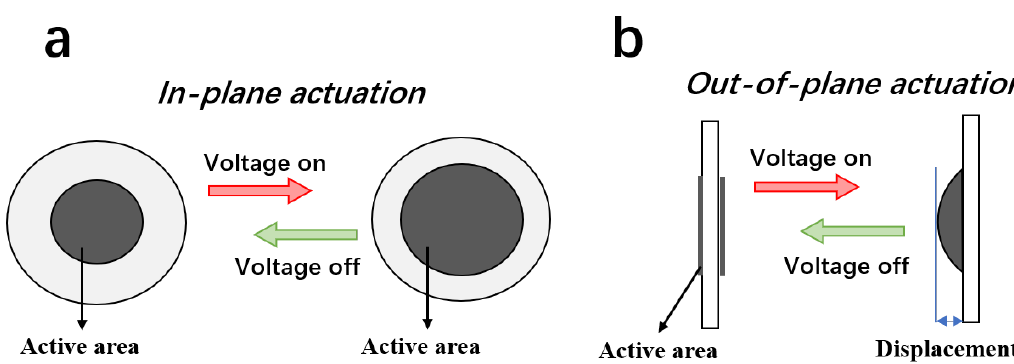
Figure 2. Schematic of the ( a ) in-plane actuation and ( b ) out-of-plane actuation.